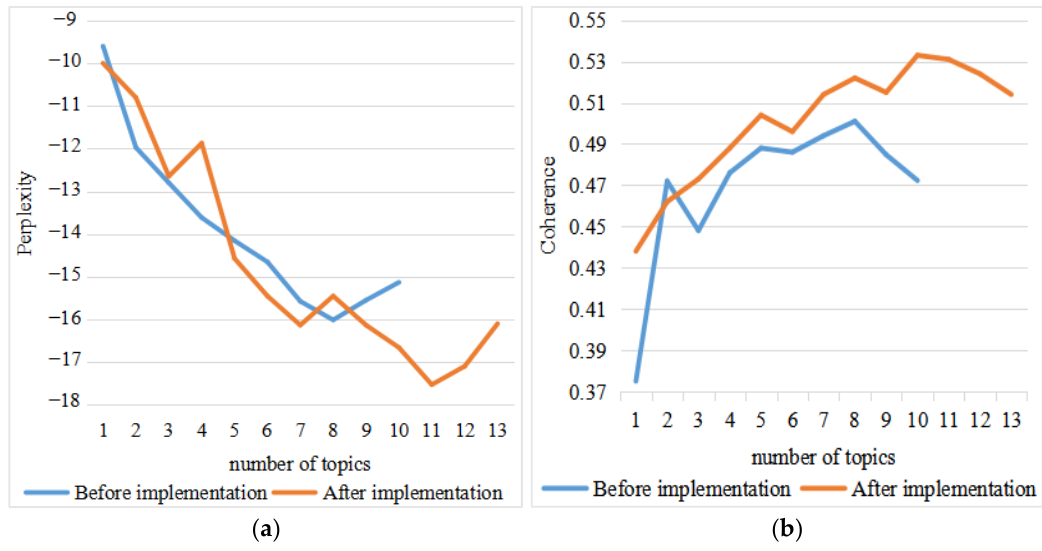
Figure 5. Best number of topics. ( a ) Perplexity; ( b ) Coherence.